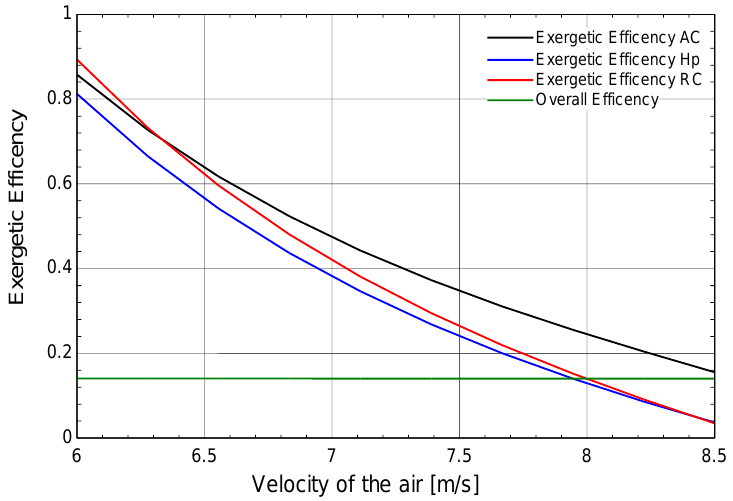
Figure 11. Effect of the velocity of the air on exergetic efficiency of the air-conditioning cycle, heat pump, refrigeration cycle, and overall exergetic efficiency.